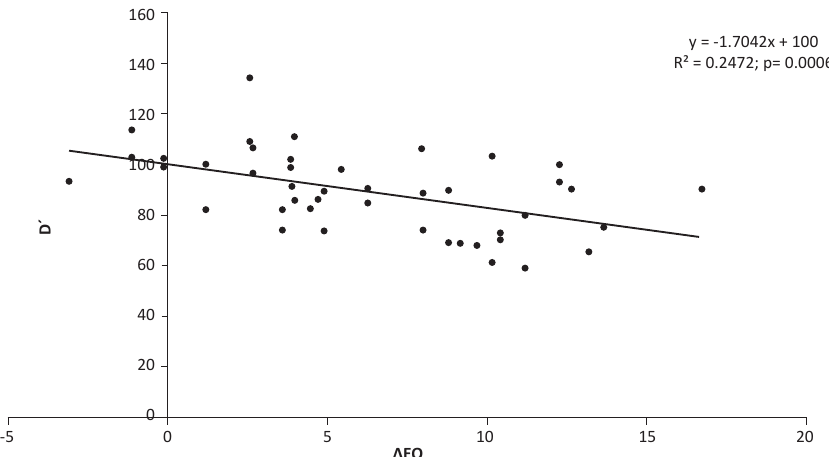
fIGUre 2. Increment decline caused by sub-optimal adaptedness. The "transfer function" defines the decline in percents of the mean diameter (D’) of the "theoretically local" provenance, in function of the change of the Ellenberg’s drought index (∆EQ). Data points are plot averages [13].